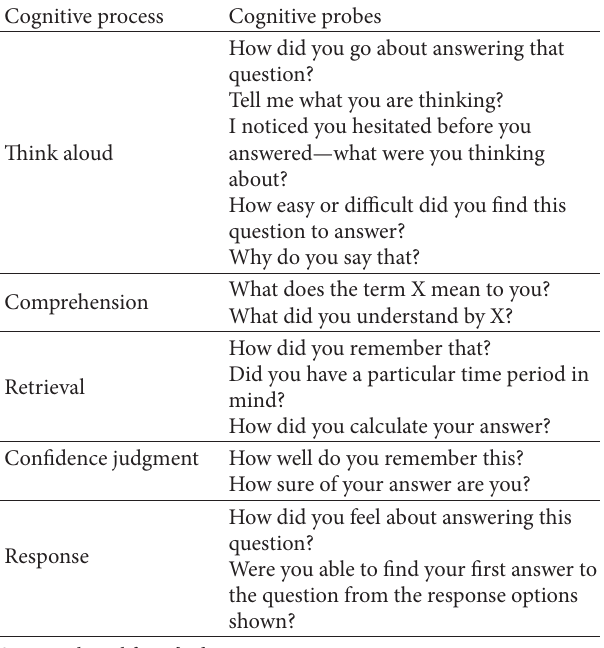
Table 6: Examples of cognitive